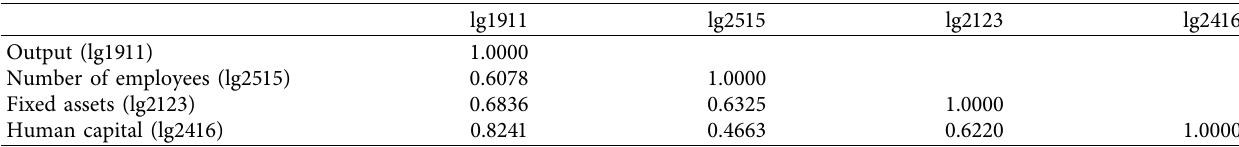
Table 4: Correlation analysis on relevant variables of manufacturing enterprises in Hubei.